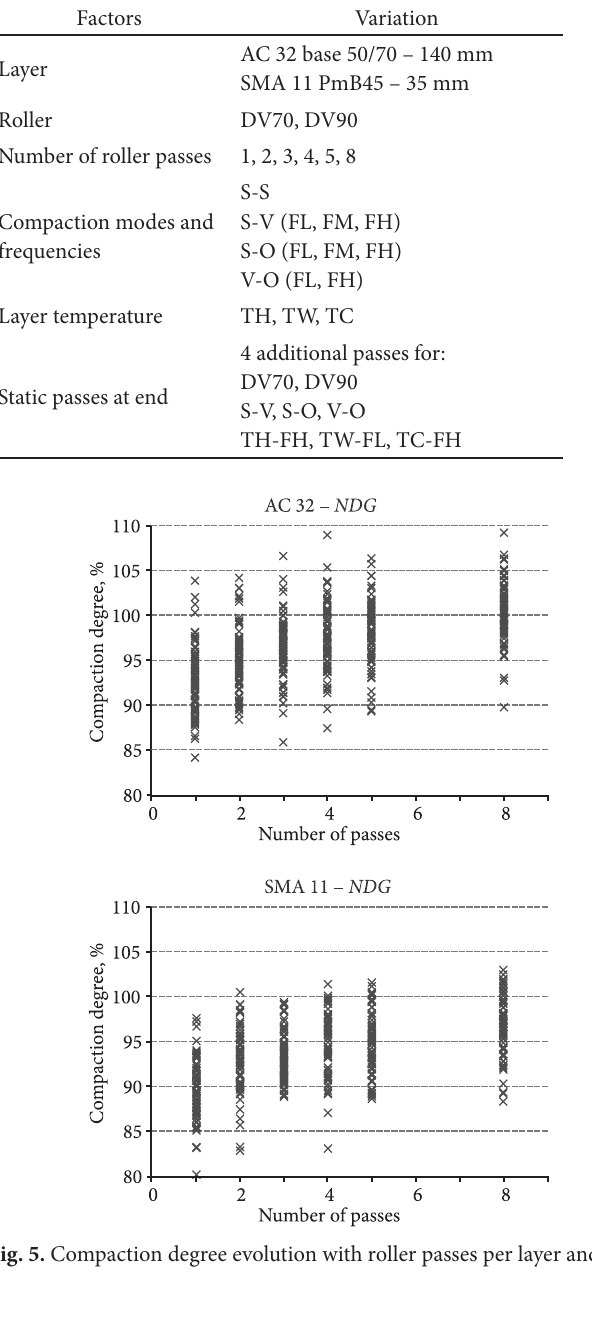
table 3. Field test factors variation list